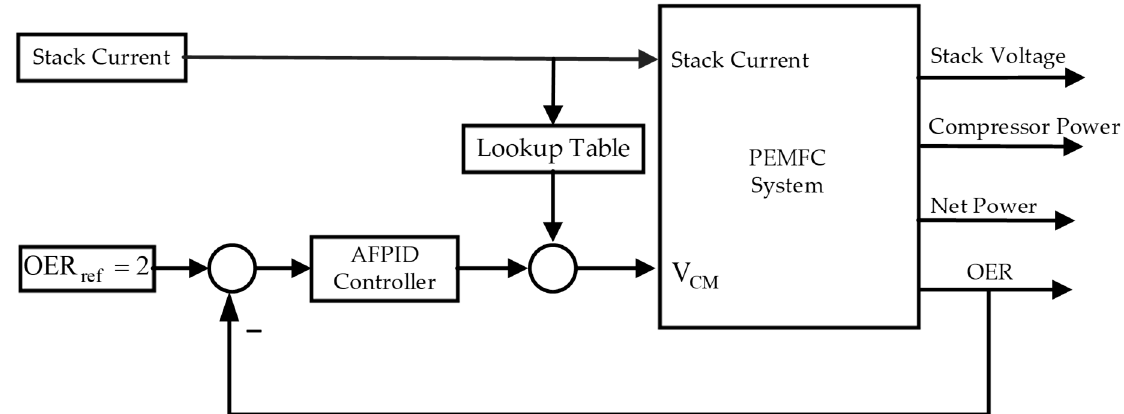
Figure 2. The adaptive fuzzy PID control framework of PEMFC.